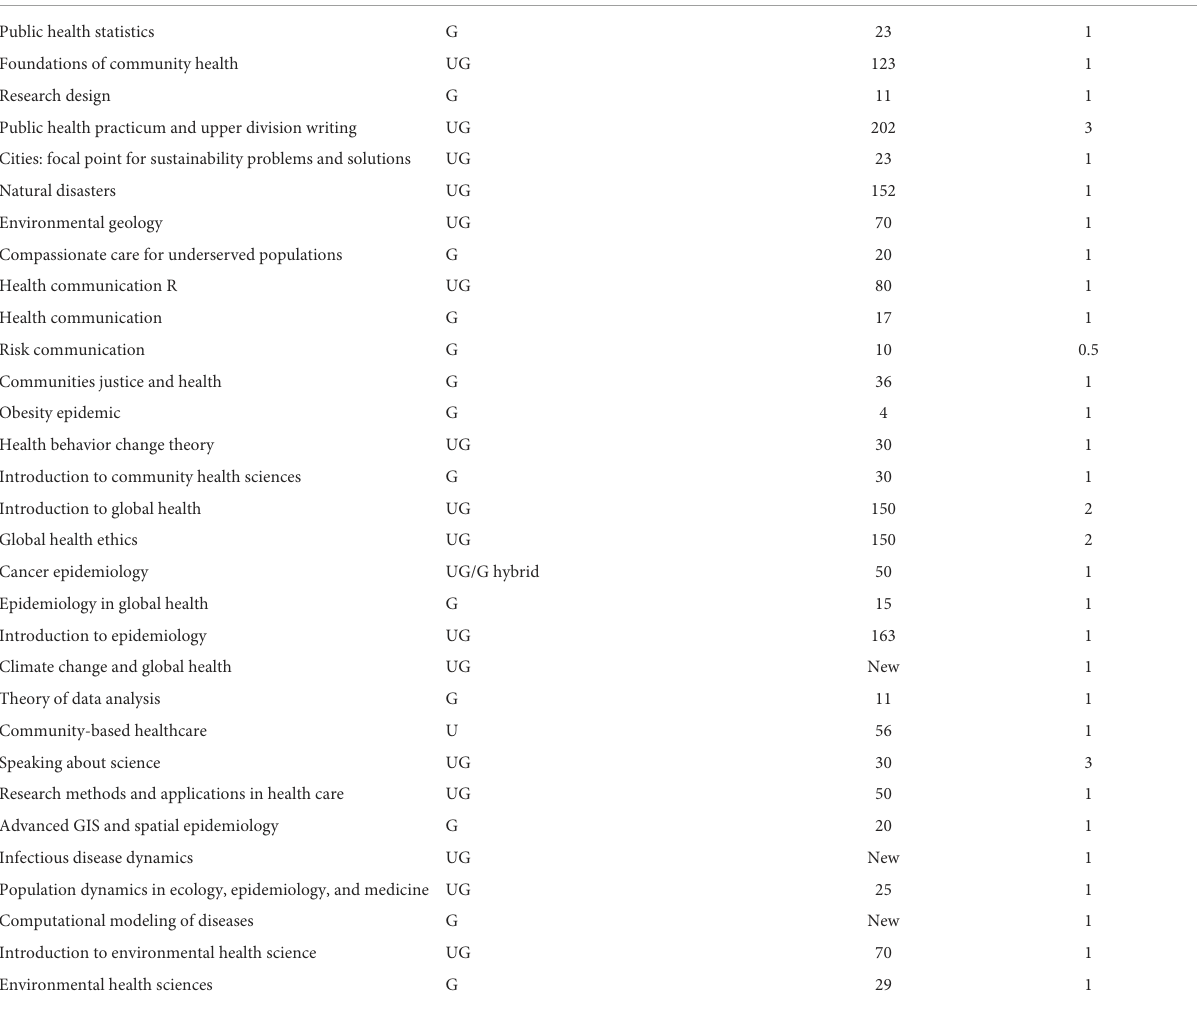
TABLE 1 Courses taught by workshop